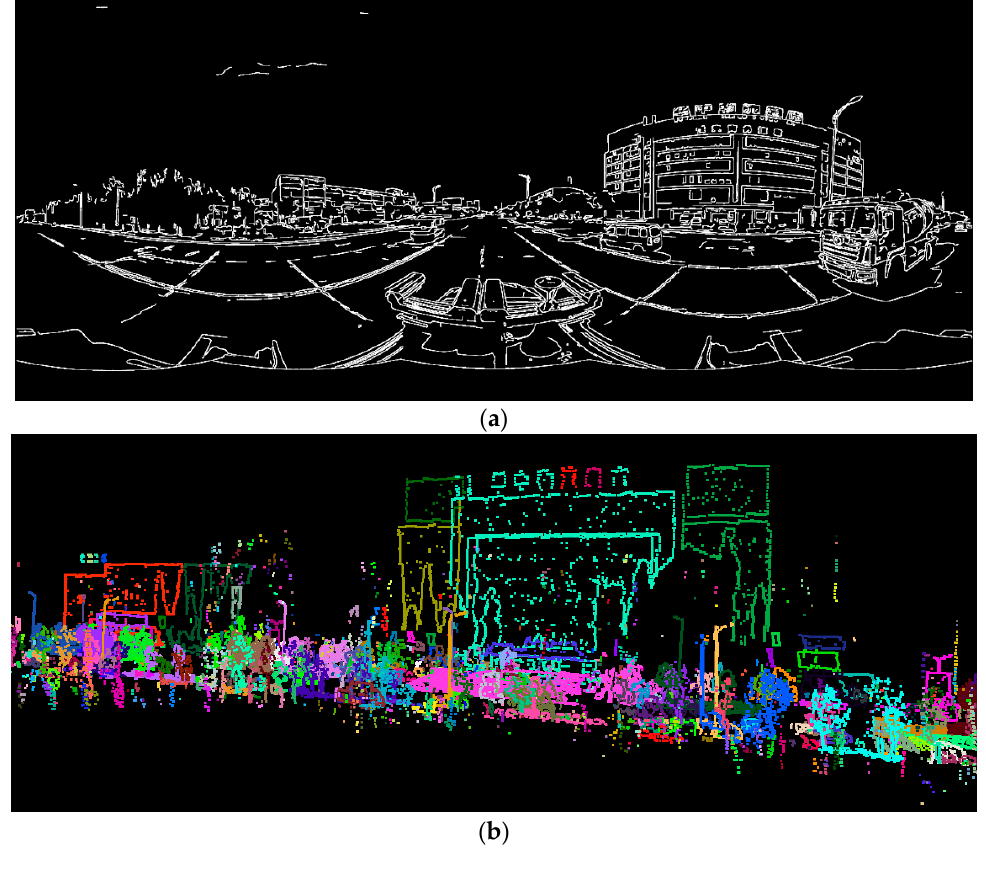
Figure 14. Linear features of the two datasets. ( a ) EDISON edge pixels in the panoramic image; and ( b ) boundary points in LiDAR point cloud.